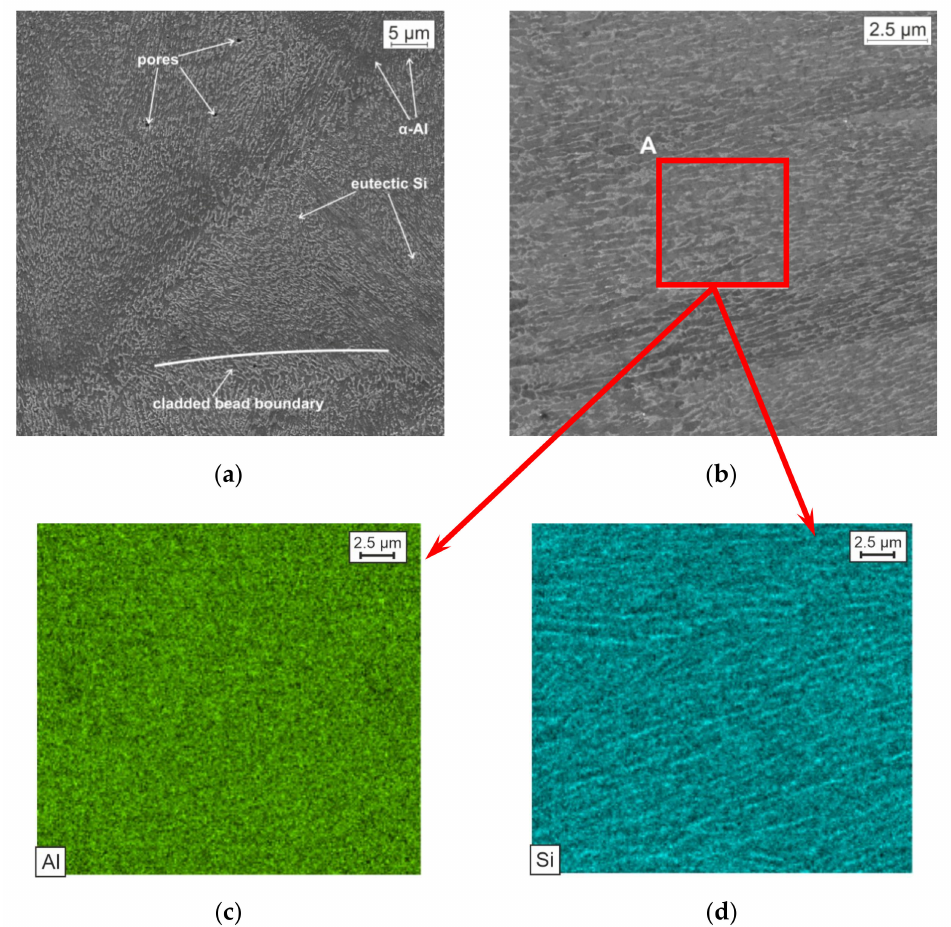
Figure 8. SE ( a ) and BSE-image ( b ) of the AlSi10Mg sample; distribution map of Al ( c ) and Si ( d ) in region A on Figure 8b